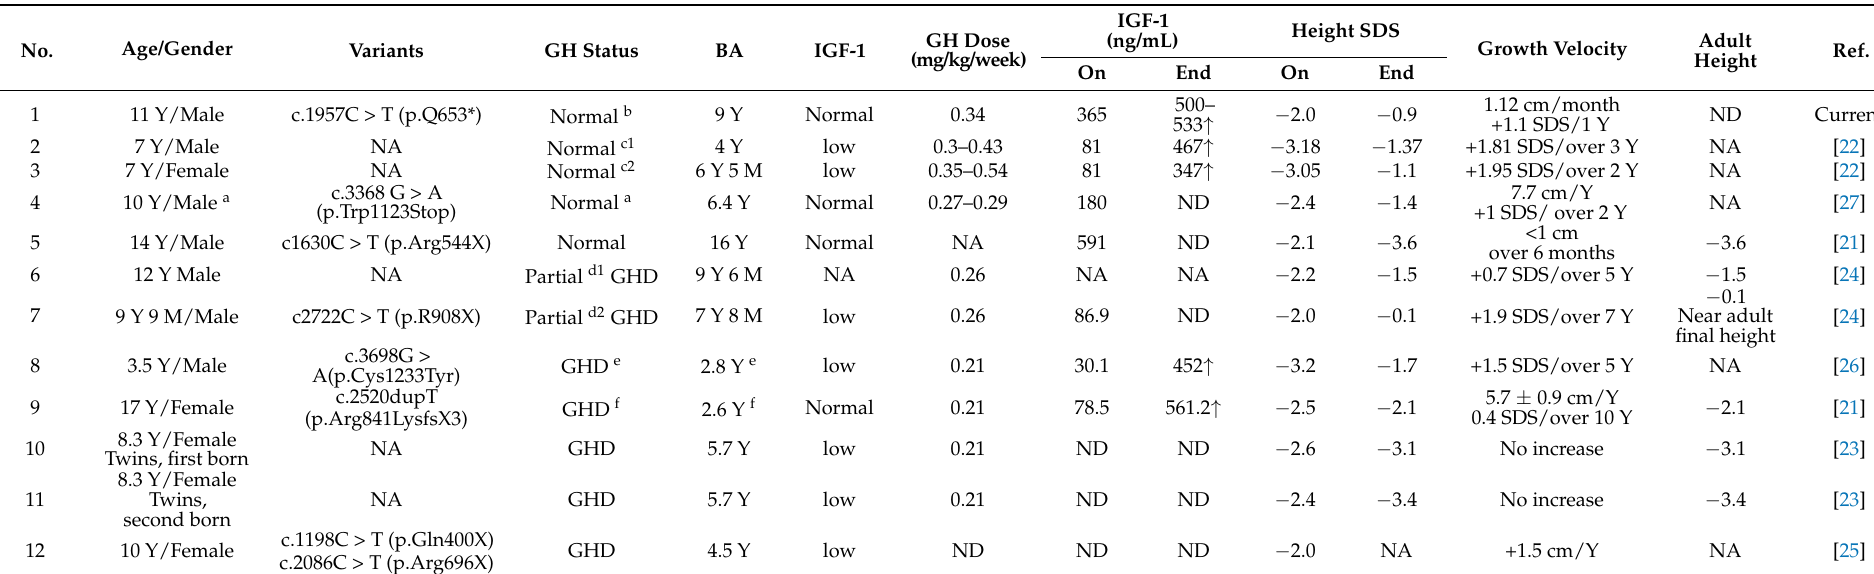
Table 1. A summary of 12 cases with TRPS1 gene variants, GH axis evaluation, and treatment in each analyzed patient with TRPS